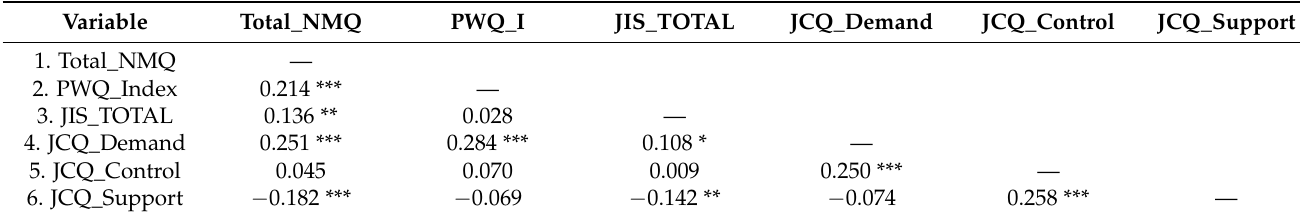
Table 3. Pearson correlation between variables.